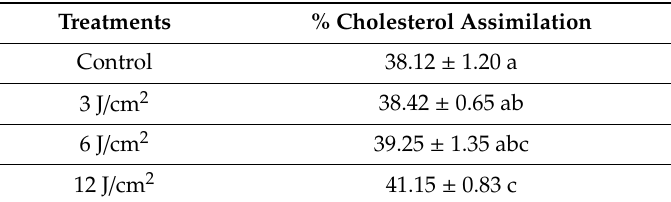
Table 3. E ff ect of red laser beam on cholesterol assimilation by L. casei before (control) and after irradiation by laser